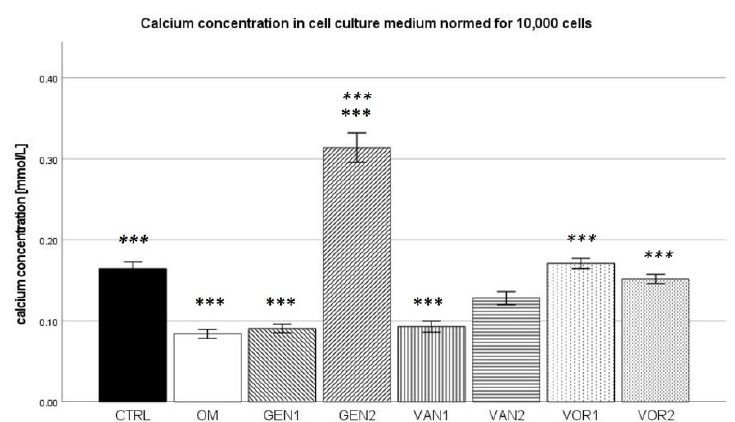
Figure 3. Mean calcium concentration per group as measured in the cell culture medium, normed for 10,000 cells. The error bars show the error of mean. Significances are indicated by stars: bold stars indicate a significance compared to the negative control CTRL, stars in italics indicate a significance compare to the osteogenic control OM. *** = significance p ≤ 0.001.